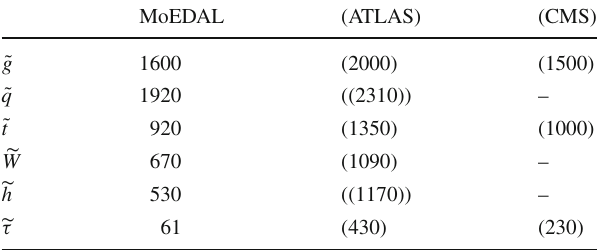
Table 1 Comparison between the MoEDAL mass reaches at Run 3 for N sig = 1, κ = 0 . 7 and (in parentheses) the current (95% CL) mass bounds on several long-lived supersymmetric particle candidates obtained (estimated in the cases of ˜ q and ˜ h , in double parentheses) from the ATLAS heavy stable charged particle search with L = 36 . 1 fb − 1 [54] (second column) and CMS [55] (third column) under the model- dependent assumptions described there and in the text. All masses